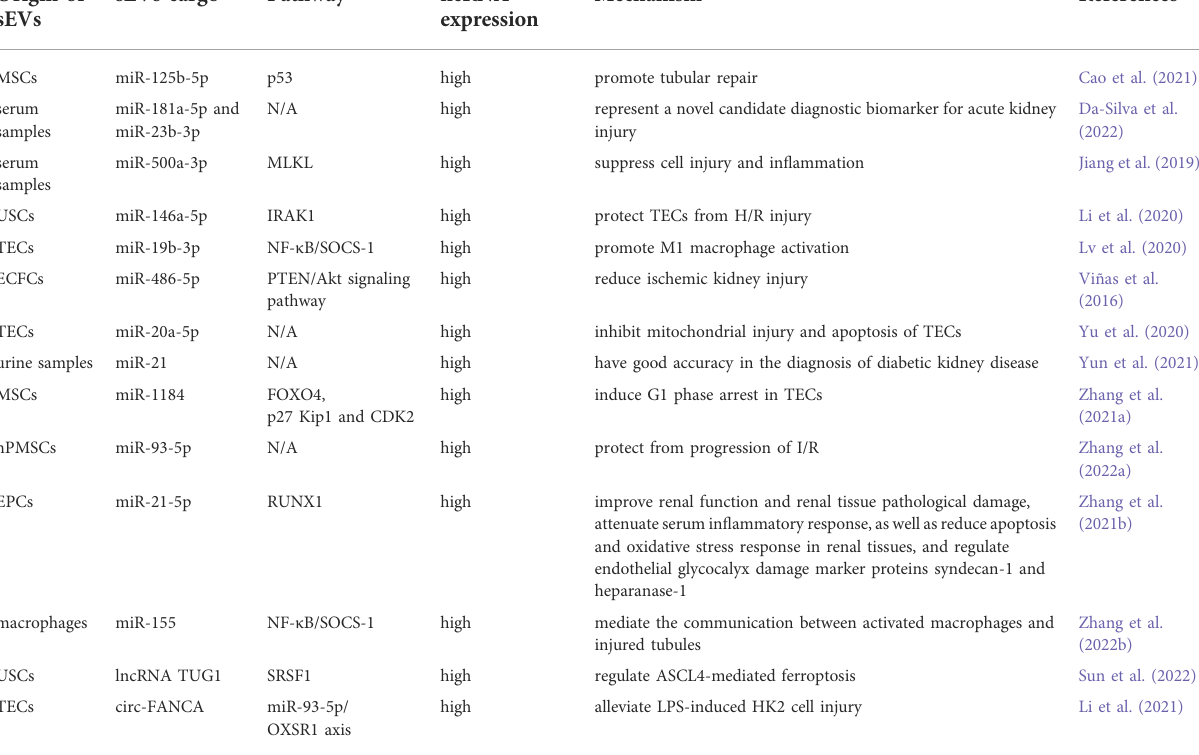
TABLE 2 The role of small extracellular vesicle non-coding RNAs in acute kidney